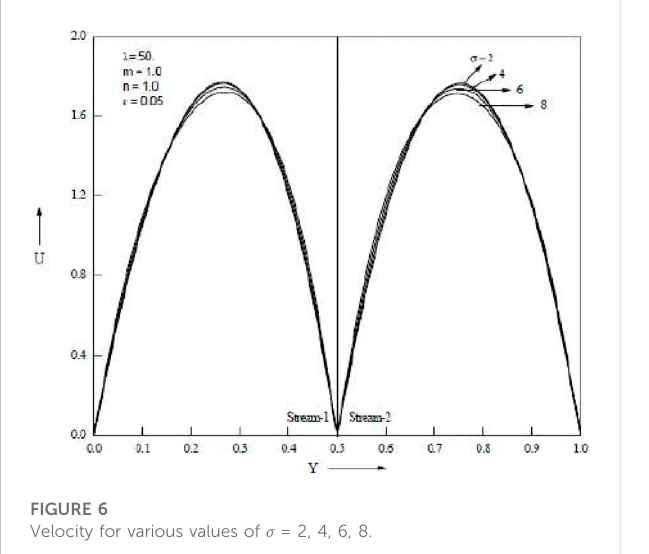
FIGURE 8 Temperature for various values of λ = 50, 100, 150, 200.